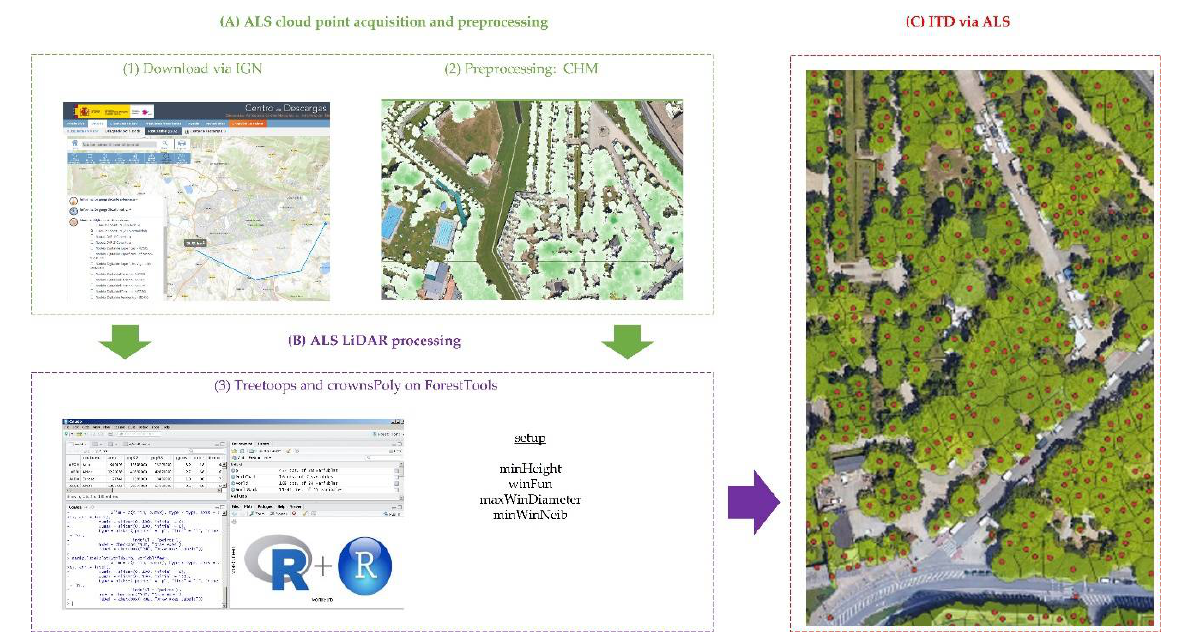
Figure 5. Graphical summary of stage 1B to perform individual tree detection based on the use of ForestTools package on LiDAR point cloud.